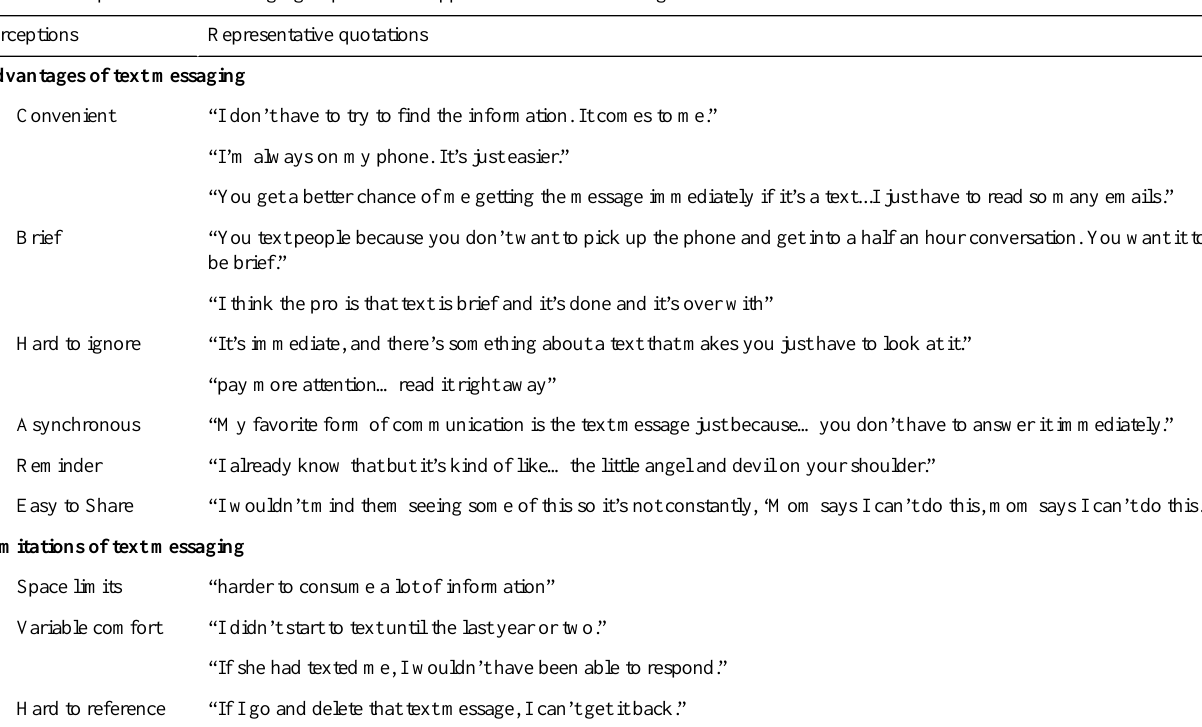
Table 2. Perceptions of text messaging to parents to support child behavior change. Representative